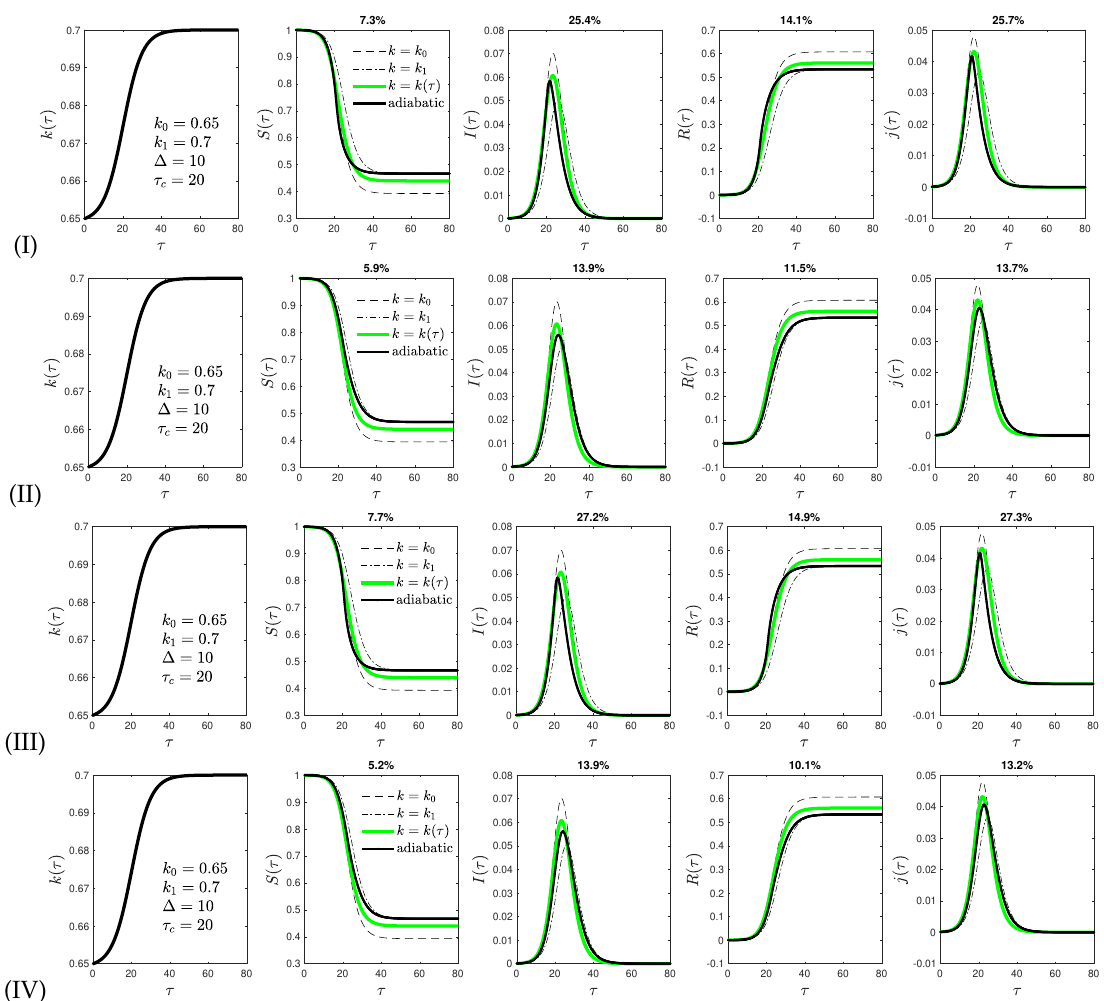
Figure 7. Same as Figure 2 but with another set of the parameters ( k 0 = 0.65, k 1 = 0.7, ∆ = 10, and τ c = 20) of the ratio k ( τ )